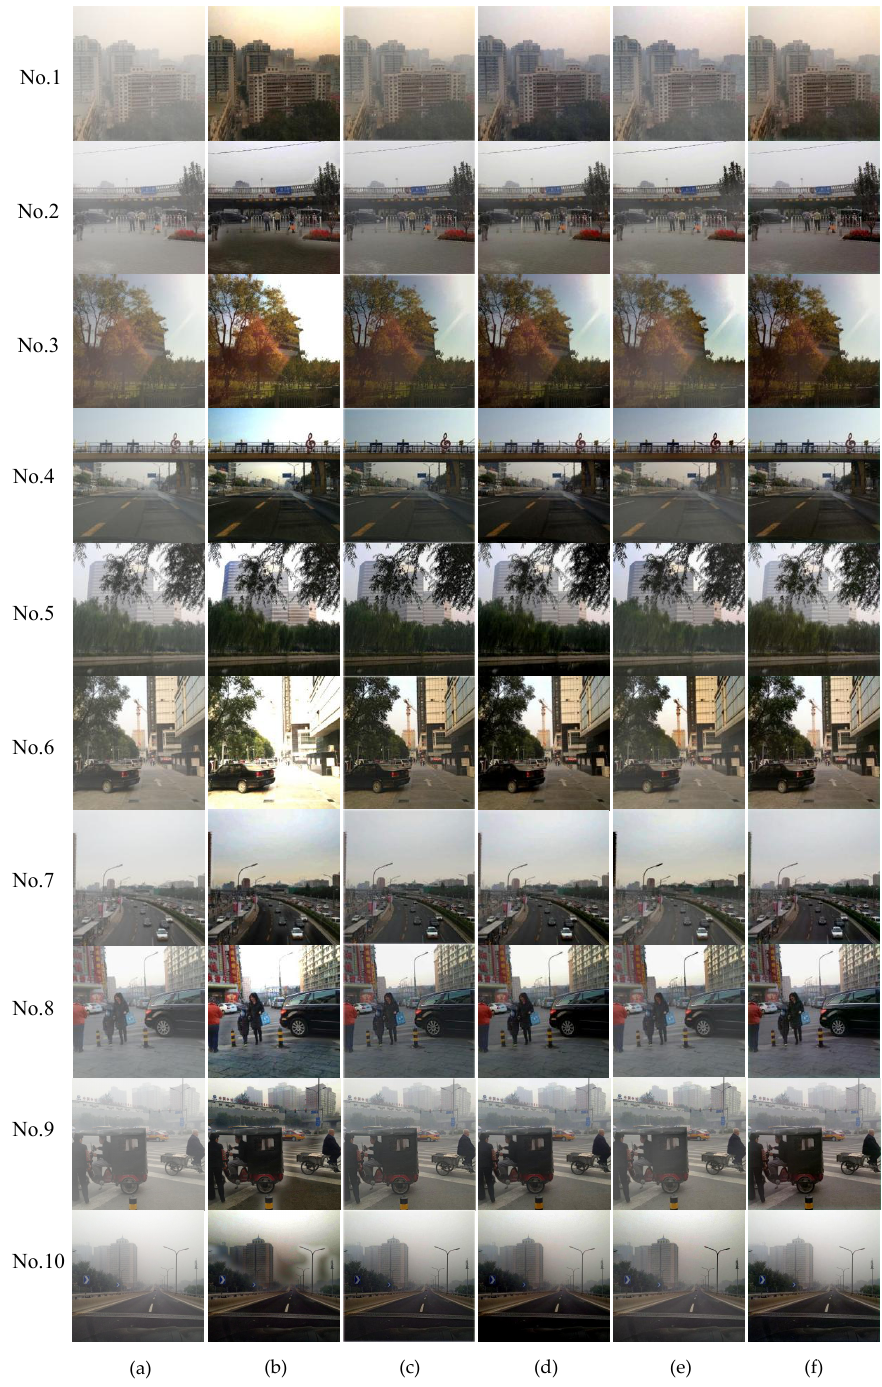
Figure 11. Visual comparison on fogging dataset. ( a ) Hazy images sample; ( b ) processed by DCP [9]; ( c ) processed by AOD [29]; ( d ) processed by DehazeNet [16]; ( e ) processed by MSCNN [17]; and ( f ) processed by the proposed method.